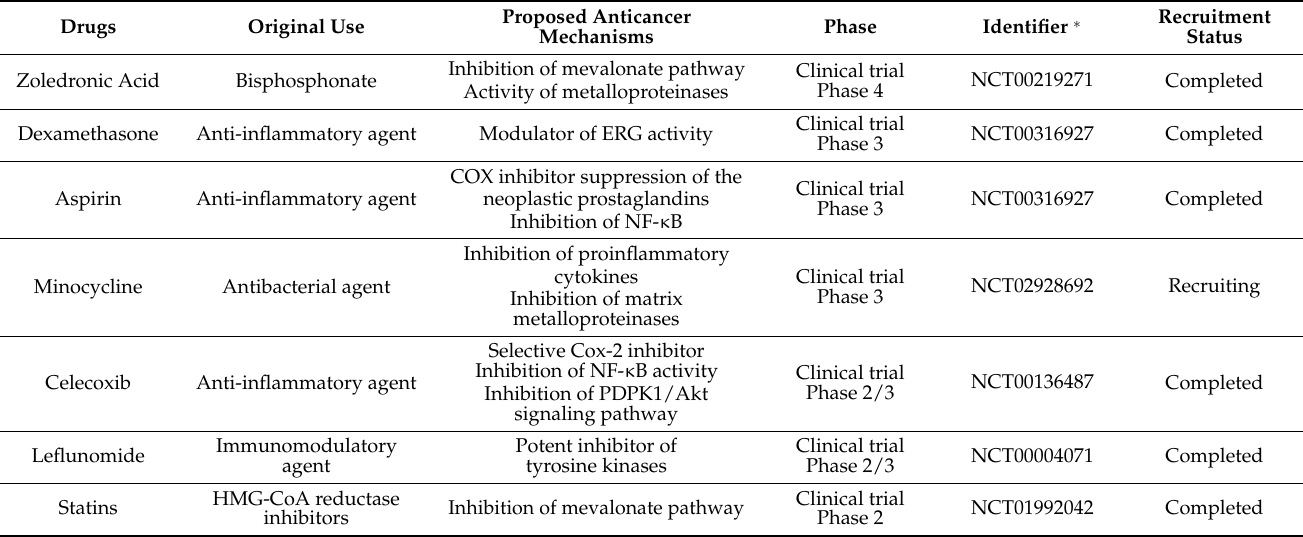
Table 7. Anticancer drug repositioning candidates under clinical investigation for the treatment of prostate cancer